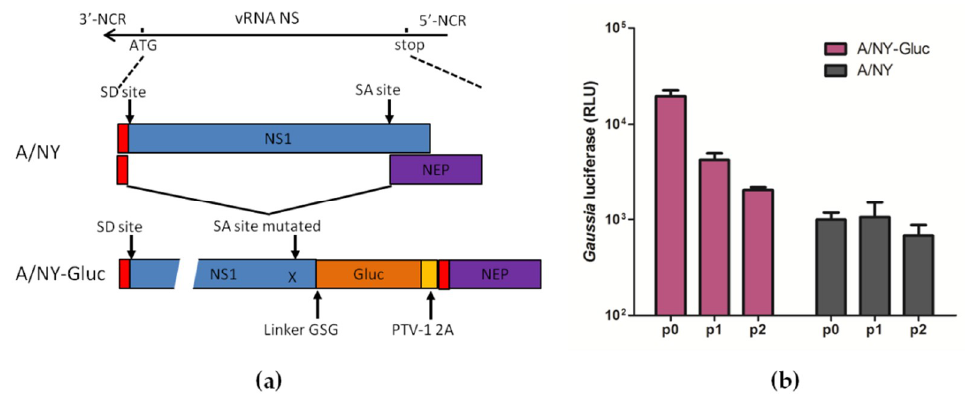
Figure 1. Generation of reporter influenza A subtype H3N2 virus by fusing Gluc gene to NS segment. ( a ) Engineering of Gluc reporter gene in the genome of influenza A NY (H3N2) virus. The porcine teschovirus–1 2A (PTV-1 2A) site allows reporter virus A / NY-Gluc to express both NS1-Gluc and NEP proteins from a single mRNA. SD / SA: Splice donor / acceptor sites. ( b ) Madin-Darby canine